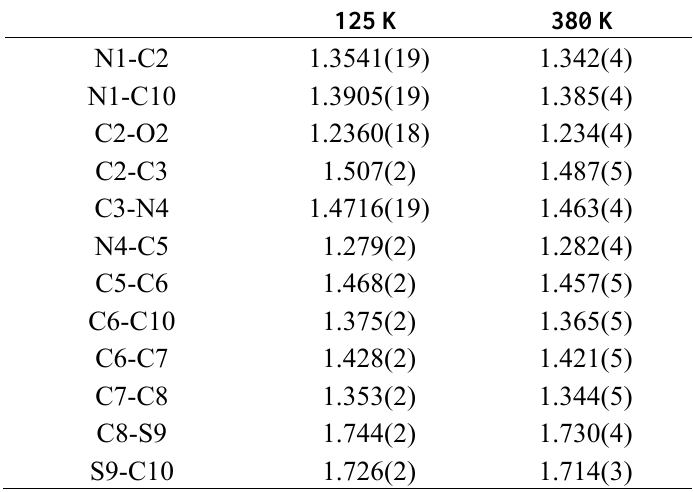
Table 1. Relevant geometrical data (Å, °) for the lowest and highest temperature. The second line, where shown, refers to the lower-occupancy